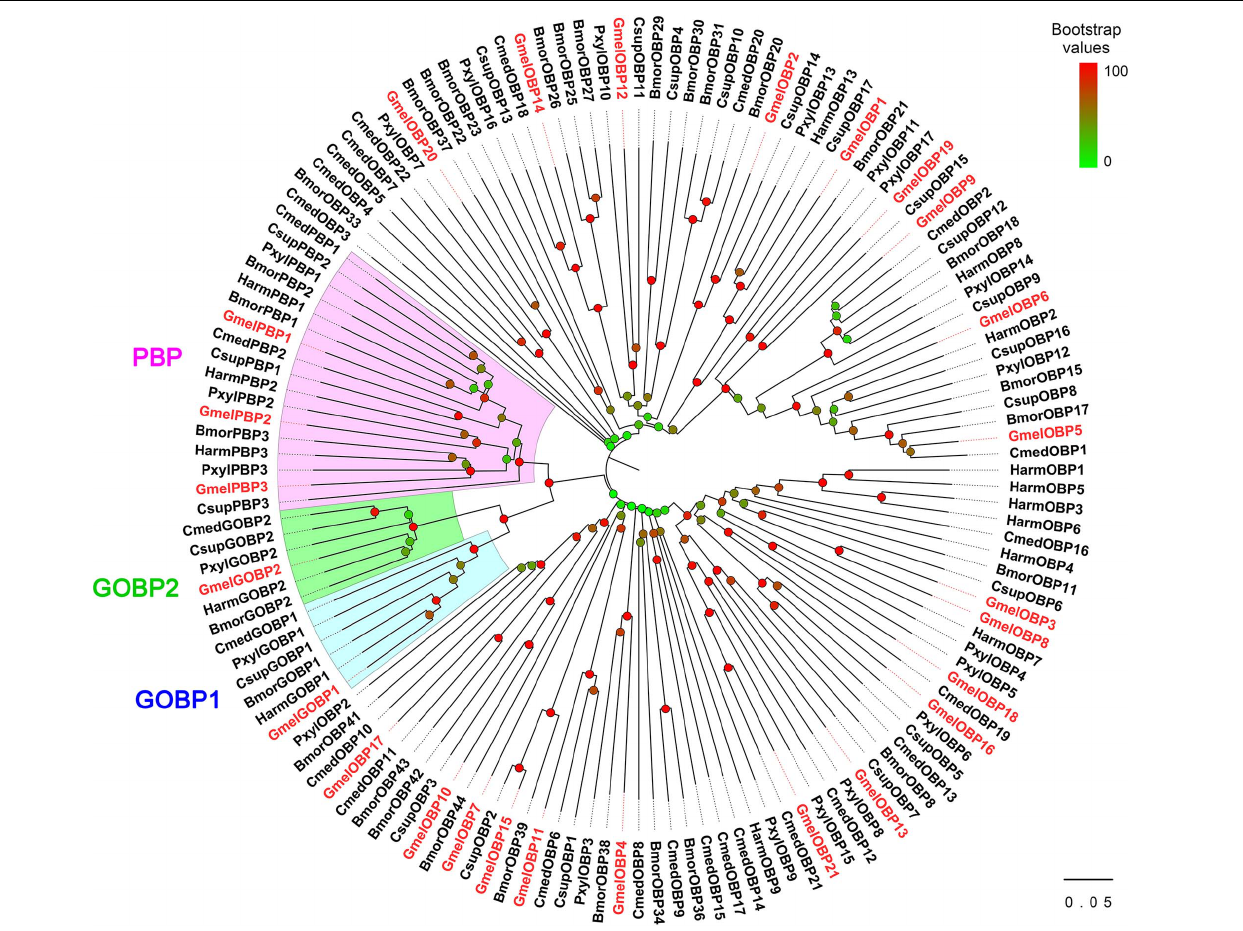
FIGURE 2 | Phylogenetic analysis of OBPs from G. mellonella (Gmel-prefix) and other lepidopterans, including Bombyx mori (Bmor), Plutella xylostella (Pxyl), Helicoverpa armigera (Harm), Chilo suppressalis (Csup), and Cnaphalocrocis medinalis (Cmed). Bootstrap values are indicated by colors from green (0) to red (100). The G. mellonella OBP s are highlighted in red. GenBank accession numbers of genes are listed in Supplementary Table 1